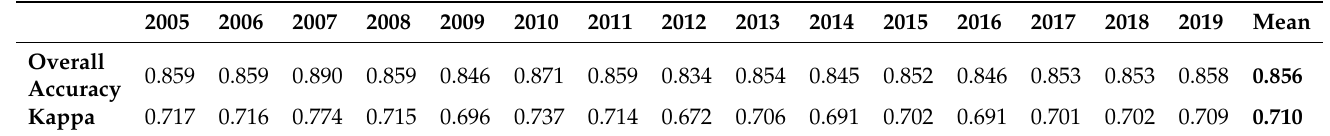
Table 2. Overall accuracies and Kappa values for classifications from 2005 to